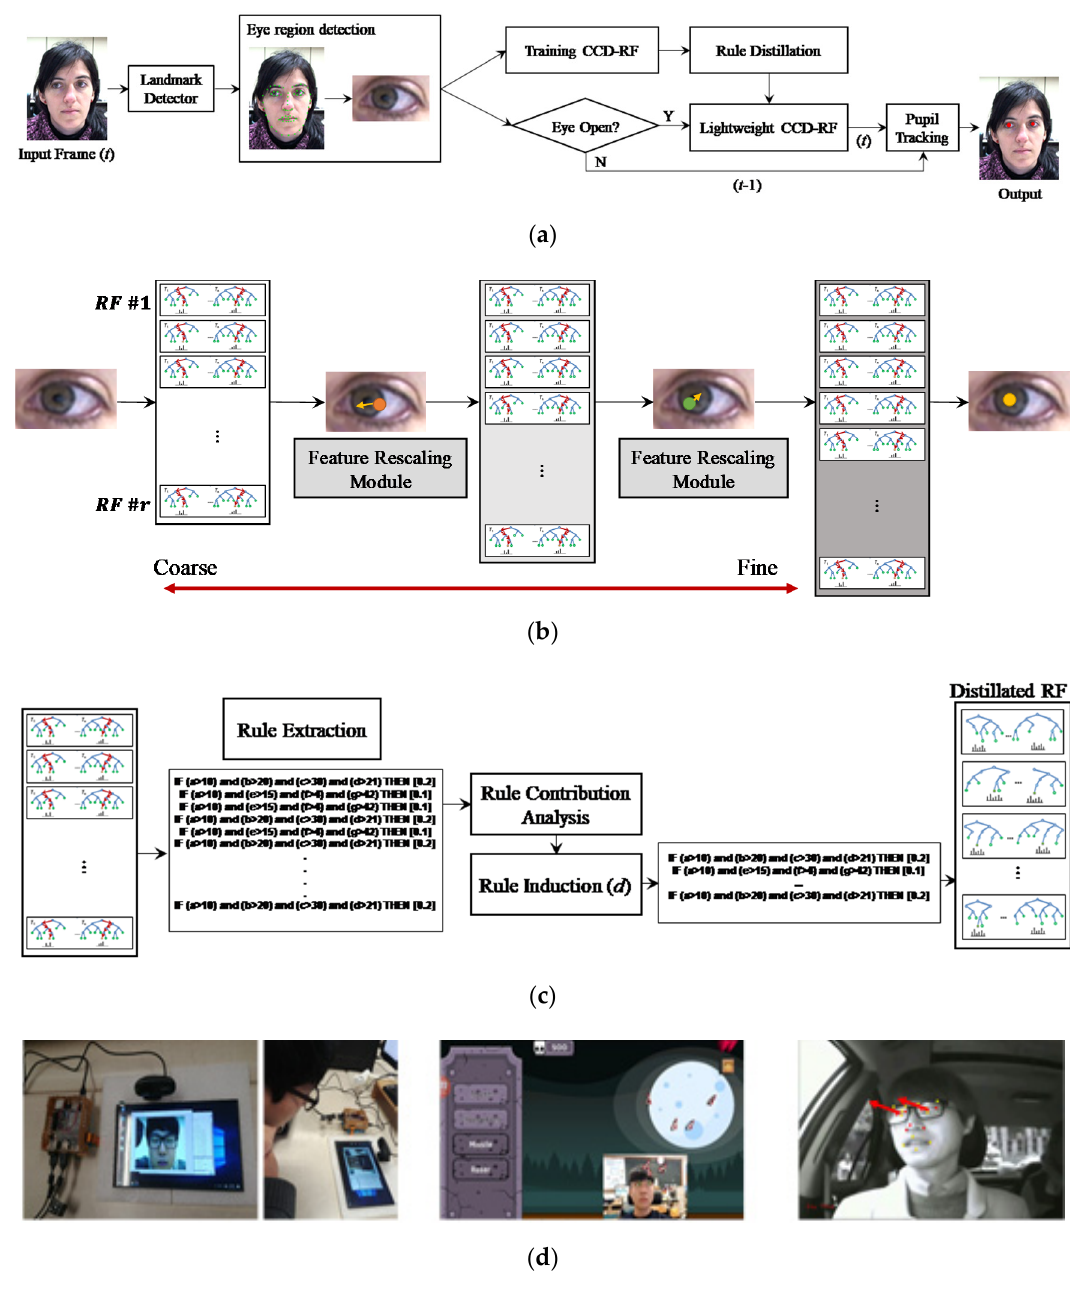
Figure 1. ( a ) Overall procedures of the proposed pupil tracking approach. ( b ) After training CCD-RF for pupil position, if the eye is opened, the pupil position is predicted sequentially using a coarse-to-fine manner of a trained CCD-RF. ( c ) The pupil tracking is applied based on the spatial relation between the pupil positions of the previous and current frames. The proposed rule distillation is applied to a trained CCD-RF and only important rules are remained per each RF. ( d ) Examples of various real-time applications where distillated CCD-RF can be applied (left: HCI tool for embedded device, middle: smartphone game, right: driver attention monitoring).